Question: In a single sentence, describe what this figure presents.
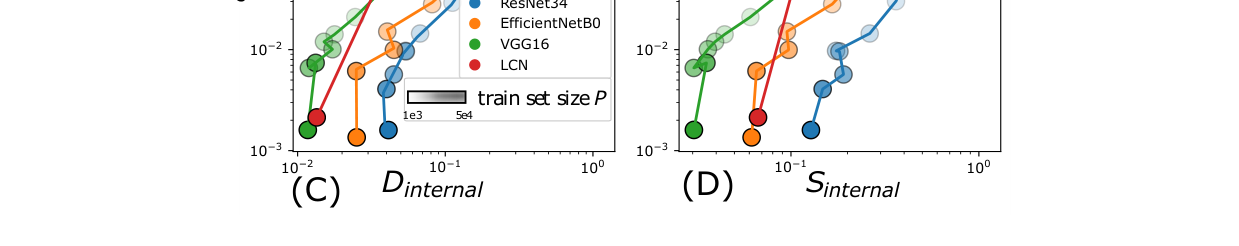
Answer: (A) Test error vs sensitivity Dinternal to diffeomorphisms of an internal deep layer for a CNN trained with P = 7400 on the SHRM model, with parameters L = s = s0 = 2 and nc = m = 10. Dinternal is defined as the change of the hidden representation induced by a diffeomorphism applied on the input, see Eq. 7. The internal layer is at 80% relative depth of the architecture, except for the 2 hidden-layer LCN, where it corresponds to the second layer. The test error shows a remarkable correlation with the sensitivities. A grey line, corresponding to a power-law, guides the eye. For details about the architectures and their training process, see Appendix B. (B) Same as (A) for sensitivity Sinternal to synonymic exchanges, defined as the change of the hidden representation induced by an exchange of synonyms applied on the input, see Eq. 6. (C) and (D): as top panels (A) and (B), for increasing P (increasing opacity). The sensitivities of the network output yield the same observatio